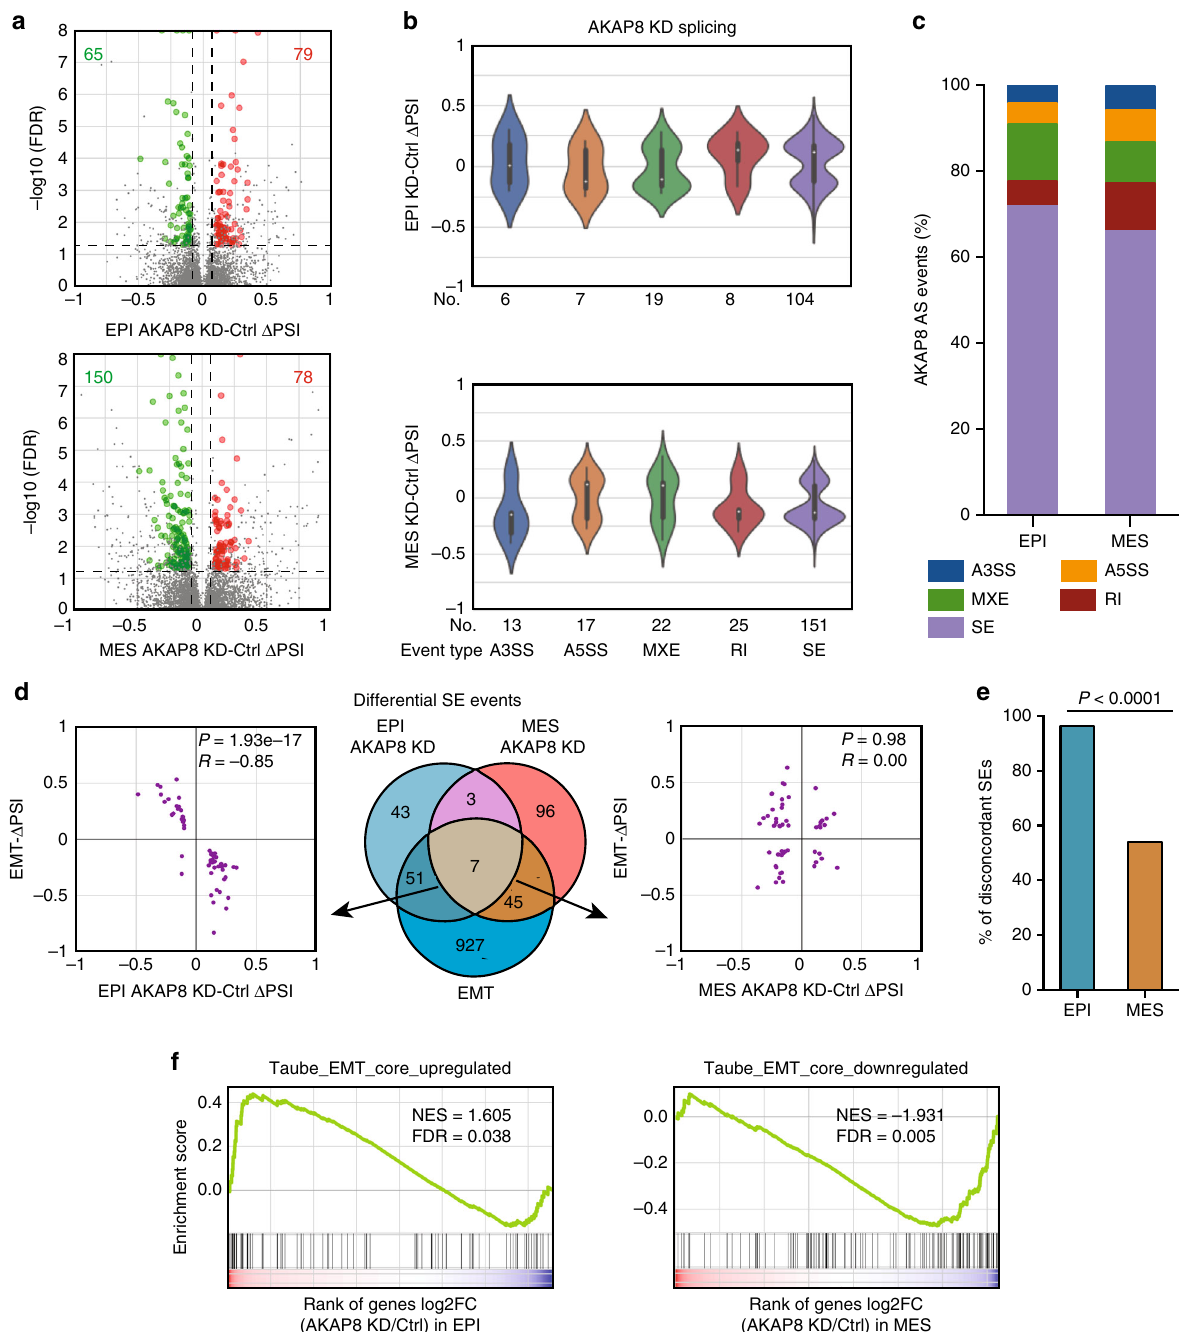
Fig. 5 AKAP8 regulates EMT in a cell state-speci fi c manner through alternative splicing. a Volcano plots showing differential alternative splicing events identi fi ed upon knockdown of AKAP8 in HMLE/Twist-ER untreated epithelial cells (EPI, top panel) and in tamoxifen-induced HMLE/Twist-ER mesenchymal cells (MES, bottom panel). Signi fi cant alternative splicing events (FDR < 0.05 and | Δ PSI| > 0.1) were colored as green and red dots if AKAP8 knockdown resulted in skipping or inclusion, respectively. PSI: Percent Splice In. b Violin plot of differential alternative splicing distribution identi fi ed upon knockdown of AKAP8 in epithelial cells (top panel) and mesenchymal cells (bottom panel) grouped by alternative splicing types. A3SS: Alternative 3 ’ Splice Site; A5SS: Alternative 5 ’ Splice Site; MXE: Mutually Exclusive Exon; RI: Retention Intron; SE: Skipped Exon. c Stacked bar graph of the proportion of different types of AKAP8-dependent alternative splicing events in epithelial and mesenchymal cells. d AKAP8-dependent SE events overlap with SEs altered during EMT (middle panel). Scatterplots of Δ PSI values between EMT-regulated SEs and AKAP8-dependent differential SEs identi fi ed in epithelial cells (left panel) and mesenchymal cells (right panel). SEs regulated during EMT and by AKAP8 in epithelial cells are highly negatively correlated ( R = − 0.85, P = 1.93e-17), whereas those in mesenchymal cells are not correlated ( R = 0.00, P = 0.98). P values were determined by hypergeometric test. e 96.6% (56/58) of epithelial AKAP8 differential SEs are discordant with EMT compared with 53.8% (28/52) of mesenchymal events. P < 0.0001 ( P computed by Fisher ’ s exact test). f AKAP8 knockdown in epithelial cells causes upregulation of genes that are upregulated during EMT (left panel), and AKAP8 knockdown in the mesenchymal state results in downregulation of genes that are downregulated during EMT (right panel). Source data are provided as a Source Data fi